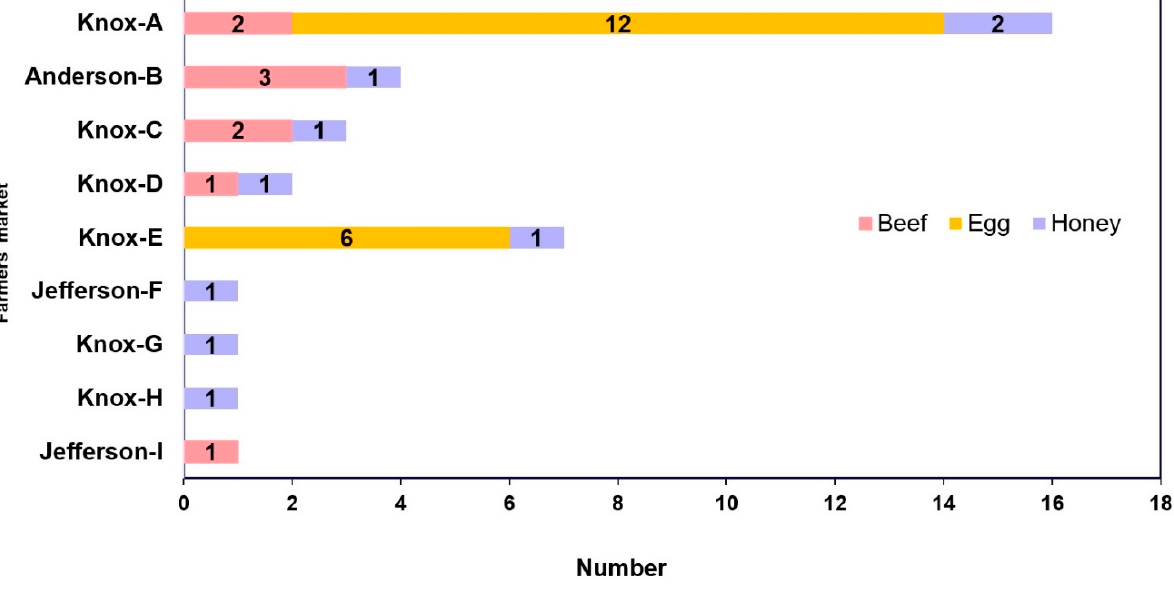
Figure 2. Distribution of food samples by farmers’ market (n = 36) from July to September 2020 in Eastern Tennessee (USA).